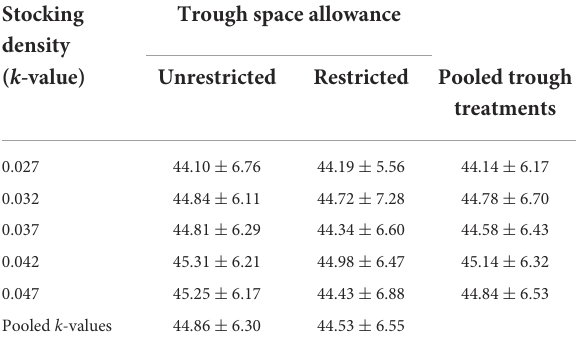
TABLE 6 Day 18 live weights (in kg) in each combination of stocking density and trough space allowance (mean ± SD; n = 72 sheep per